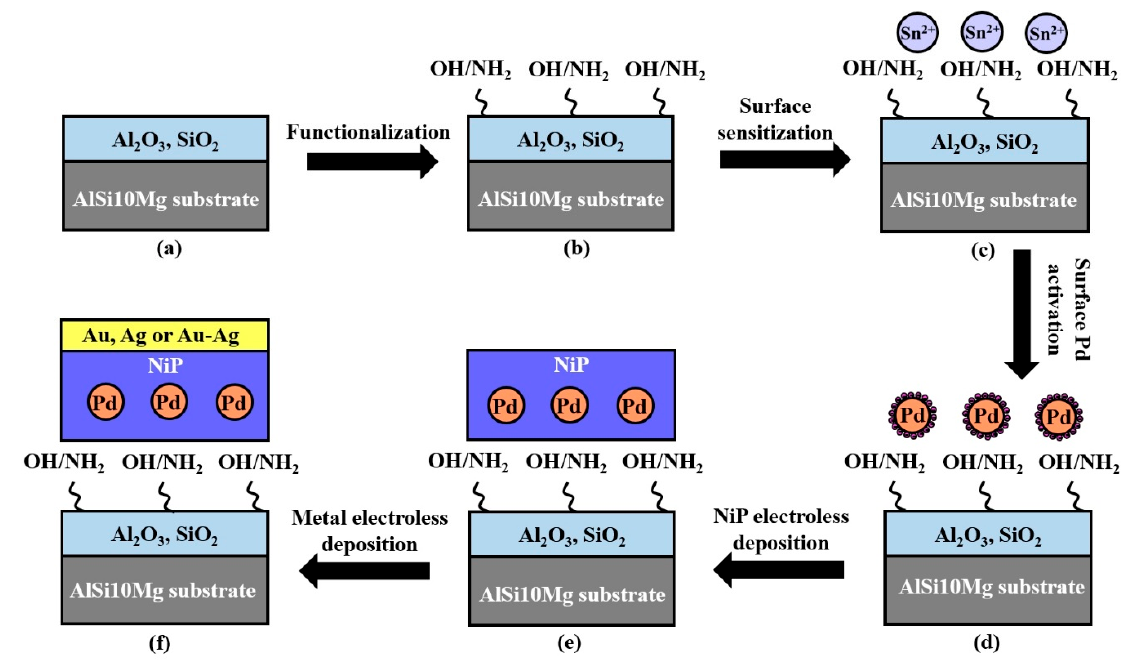
Figure 3. Schematic illustration of the gold, silver, and electrum electroless plating process developed for the AM-LPBF AlSi10Mg surface coating: ( a ) The 3D-printed AlSi10Mg substrate covered with native oxide (Mg is not presented here since AlSi10Mg contains less than 0.5 wt.% Mg); ( b ) surface functionalization: sodium dodecyl sulfate (SDS)/silanization; ( c ) surface sensitization (optional), ( d ) surface Pd activation; ( e ) deposition of Ni–P interlayer (optional); and ( f ) electroless deposition of metal coating [42,43,48]. Table 2. The electroless silver bath composition. Adapted with permission from [26,42]. Copyright